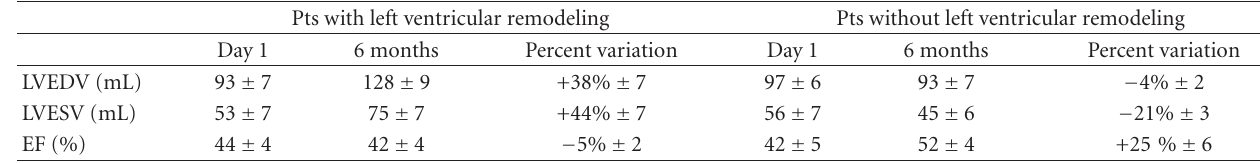
Table 2: Echocardiographic